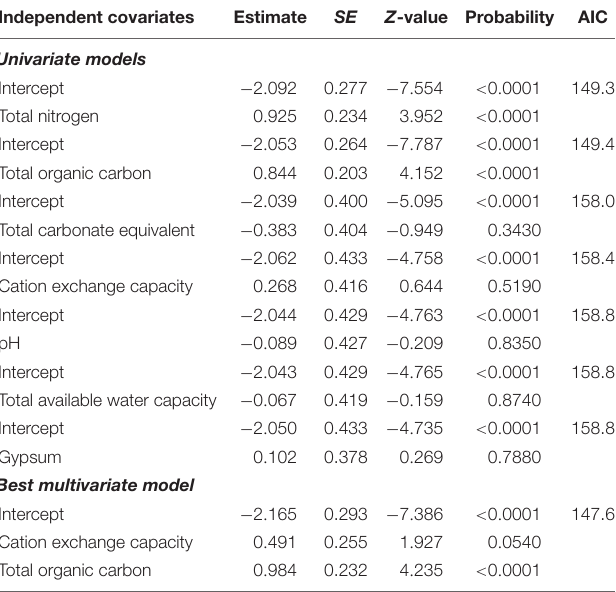
TABLE 10 | Univariate models and the best multivariate model for the influence of edaphic factors on the number of months anthrax mortality occurred in a year in focal wildlife areas.